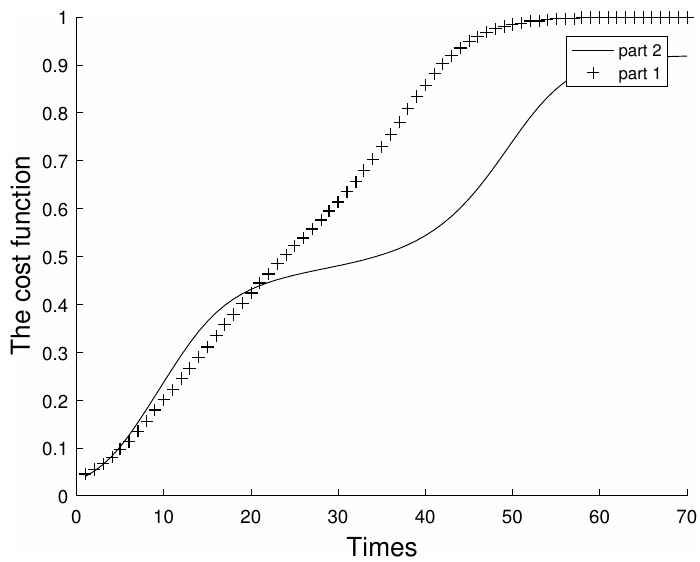
Figure 8. The cost function for the QNNs of two